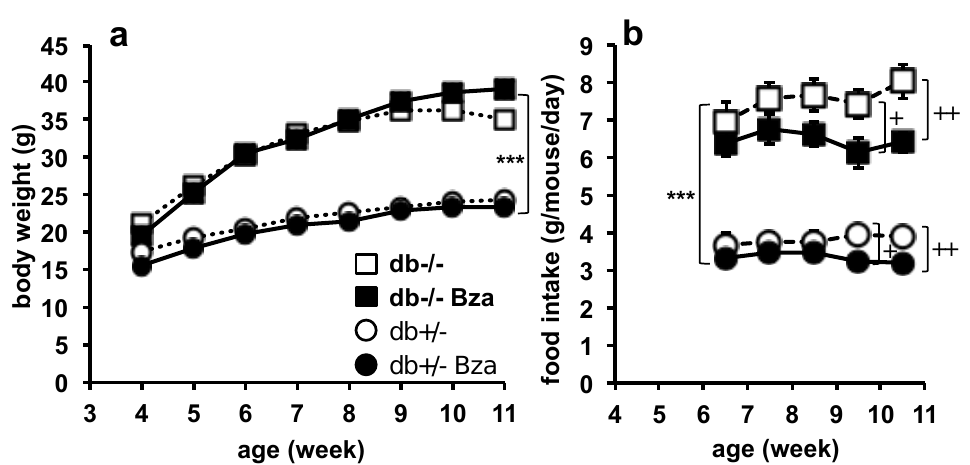
Figure 4. Influence of benzylamine supplementation on body weight gain and food intake in db-/- and db+/- mice. ( a ) Body weight of db-/- (squares) and db+/- mice (circles) drinking water (open symbols) or Bza 0.5% (closed symbols). ( b ) Average daily food intake. Mean ± SEM of n = 28 (17 males/11 females) for db-/-; 18 (9/9) for Bza-drinking db-/-; 21 (12/9) for db+/-; 14 (7/7) for Bza-drinking db+/- mice. From the age of 6 weeks, difference according to the genotype was significant at: *** p < 0.01. Significant difference at: + p < 0.05; ++ p < 0.01 for db-/- vs. Bza-db-/-, and for for db+/- vs. Bza-db+/- mice.